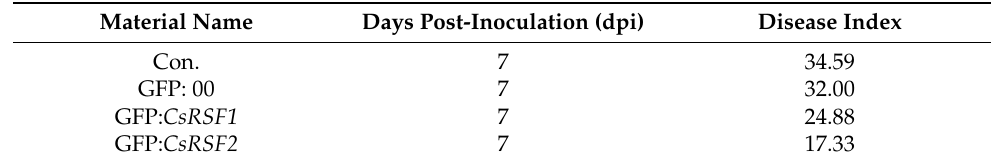
Figure 8. Identification disease-resistance of CsRSF1 / CsRSF2 - overexpressing plants after S. fuliginea infection. ( A ) Phenotypic analysis for CsRSF1 and CsRSF2 transient overexpressing cucumber cotyledons after S. fuliginea infection. ( B ) Coomassie brilliant blue staining for examining CsRSF1 and CsRSF2 transient overexpressing cucumber cotyledons after S. fuliginea infection. Con. indicates non-injected plants, GFP:00 indicates GFP:00-injected plants, GFP: CsRSF1 / CsRSF2 indicates overexpressing plants. Bars = 100 µm. Table 3. Disease index investigation for CsRSF1 and CsRSF2 transient overexpressing cucumber cotyledons after S. fuliginea infection.